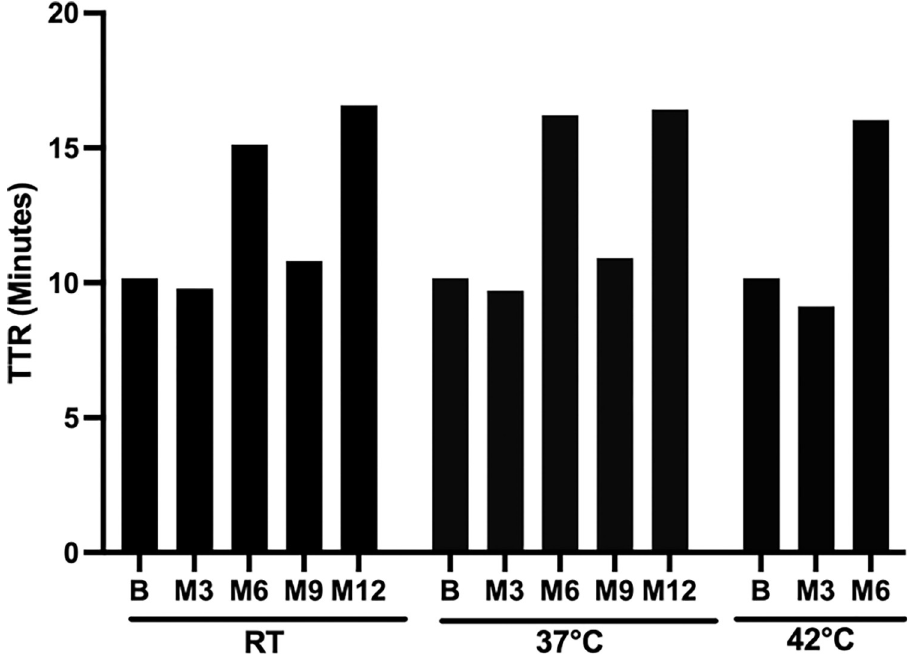
Fig 4. Stability of the dry cholera RLDT. The cholera lyophilized reaction tubes (LRT) strips were stored at room temperature (RT), at 37˚C, and 42˚C. LRT strips were tested using the RLDT kit at three months intervals and the Time to Results (TTR) were